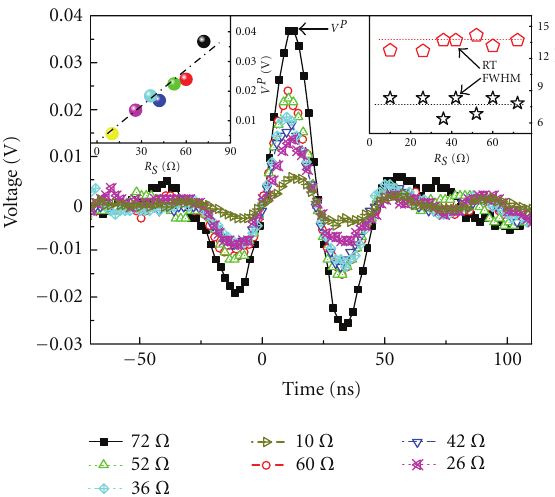
Figure 2: Waveforms for di ff erent load resistance R S at V b = 0V under the 248 nm laser illumination. The left inset shows the dependence of V P on R S . The right inset displays the RT and FWHM as functions of R S